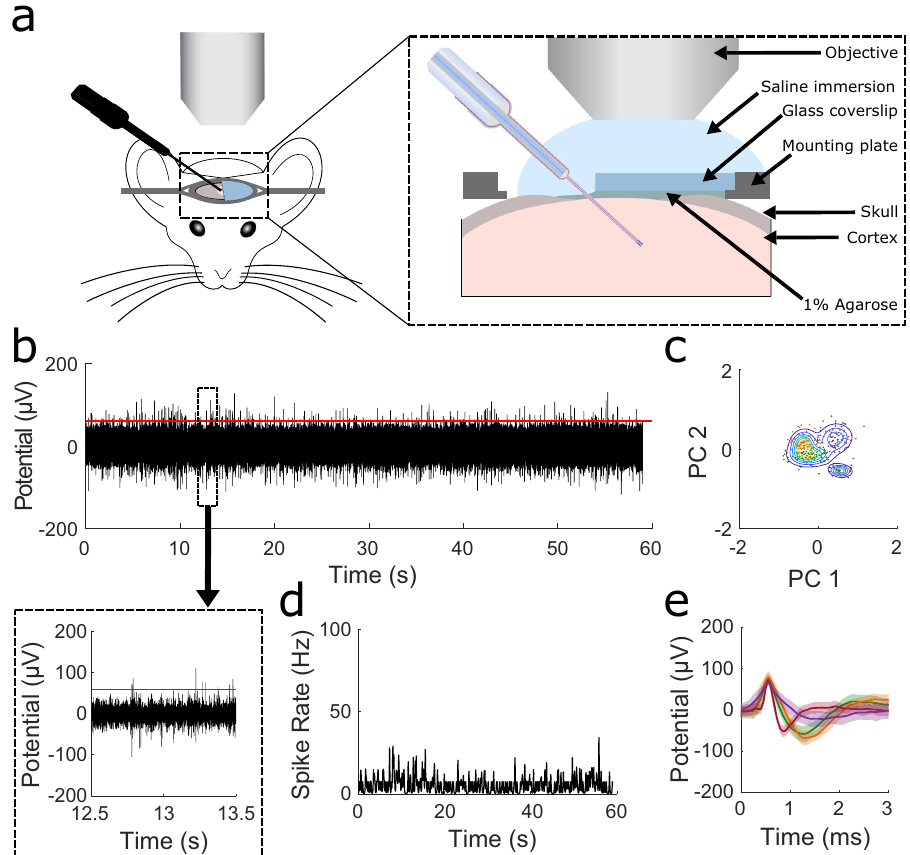
Fig. 2 Extracellular neural recordings in the cortex of live mice using the EO-Flex probes. a Schematic showing the setup used for visually guided electrical measurements. Two-photon imaging of the probe in relation to fl uorescently labeled cells (see Methods) was used to track its movement through tissue and optimize the recording position. (inset) Zoom-in cross-sectional view of the surgical preparation for simultaneous imaging and electrical recordings. b Example EO-Flex recording showing spontaneous neural activity in cortical layer 2/3 (depth = 250 µ m) of an iso fl urane-anesthetized mouse. The threshold (red line) de fi ning a spike was set to Threshold ¼ 4 (cid:2) median Recording j excerpt from the recording shows multi-unit activity. c Principal component (PC) analysis plot of the waveform clustering using established clustering methods 37 . d Spiking rate over the 1-min recording shown in ( b ) was calculated using a Bayesian kernel estimation. e Average waveforms (solid lines) along with one standard deviation (shaded regions) for four clusters determined by PCA from the recording in ( b